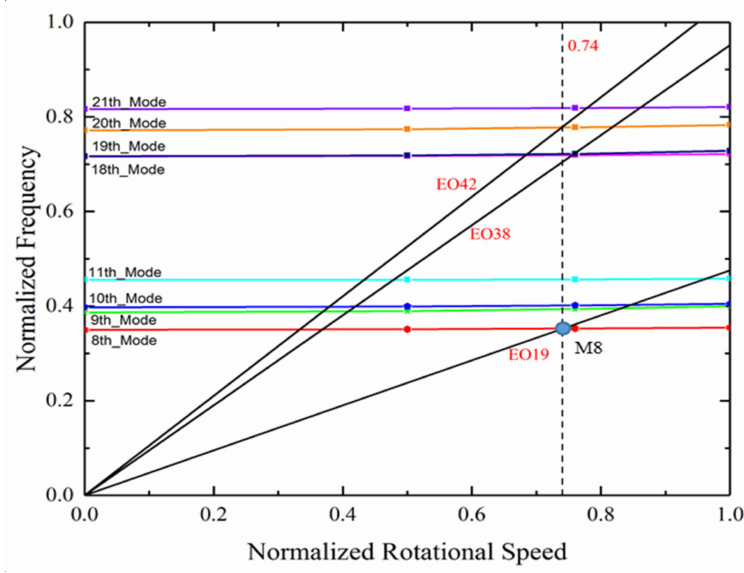
Figure 6. Campbell diagram for the BPF and